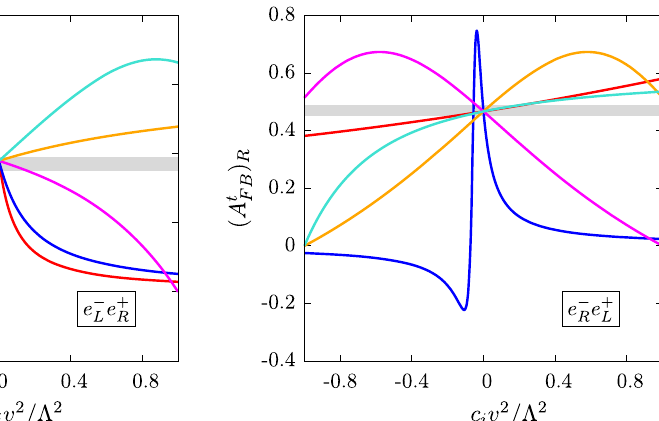
GeV, the operator colour coding is the same as Fig. 1. We also show a 5%uncertaintybandaroundtheSMprediction,toestimatetheexpected √ s = 500